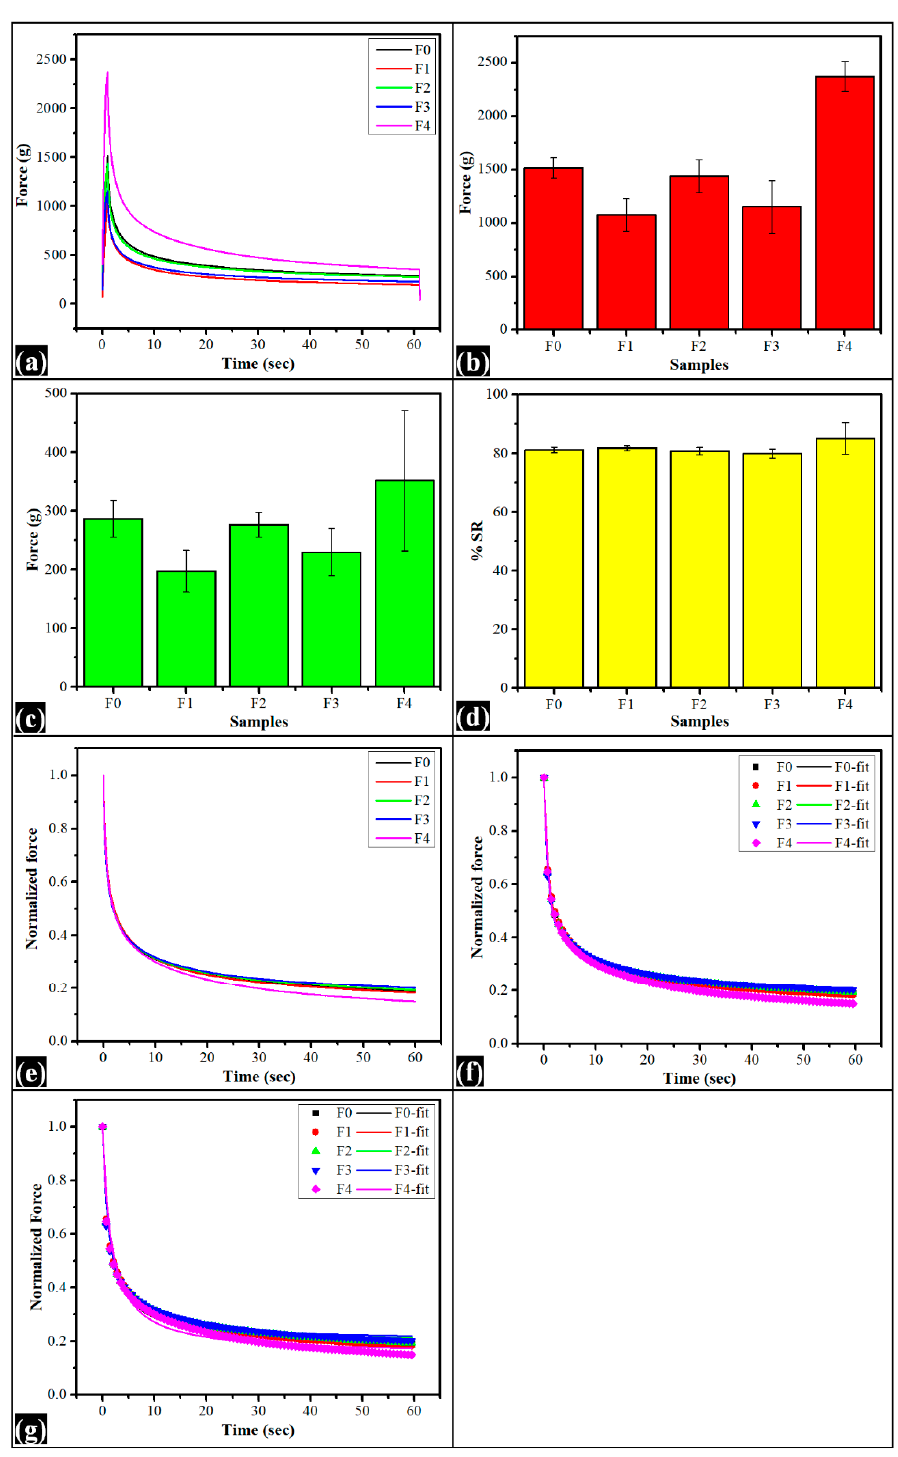
Figure 9. Mechanical parameters of the films: ( a ) Stress relaxation profiles, ( b ) F max , ( c ) F min , ( d ) %SR profile, ( e ) normalized stress relaxation profiles, ( f ) Wiechert modeling, ( g ) Peleg’s model fitting. The data are represented as average ± standard deviation of